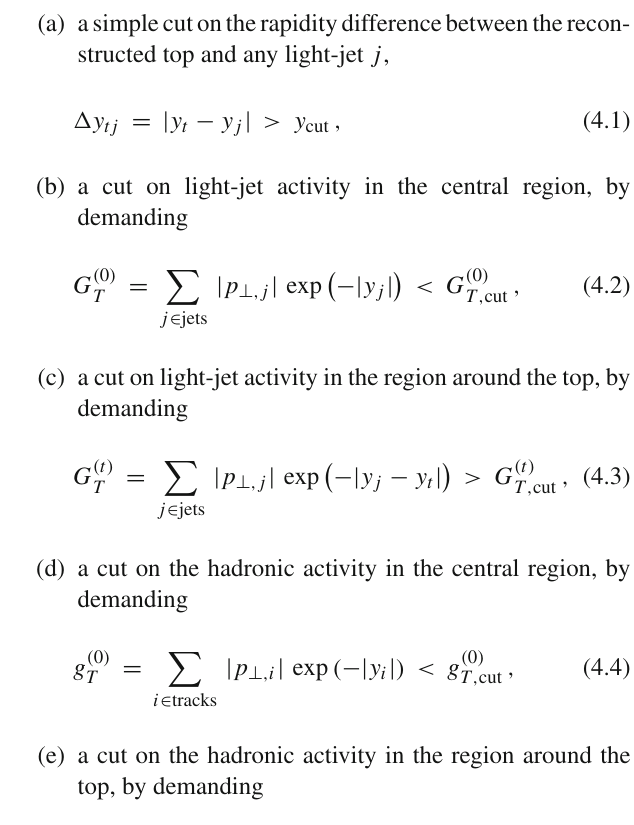
can be explored with competitive statistical